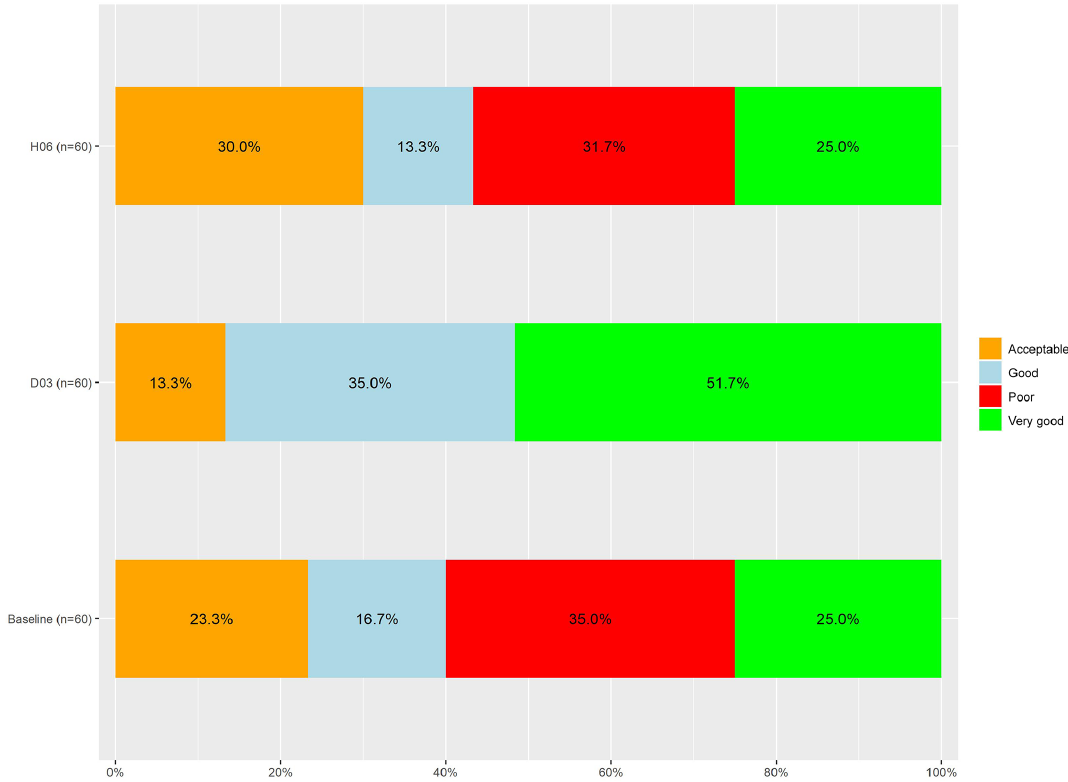
Figure 4. Proportional bar chart comparing the baseline outflow estimation and the best KGE results for D03 and H06.